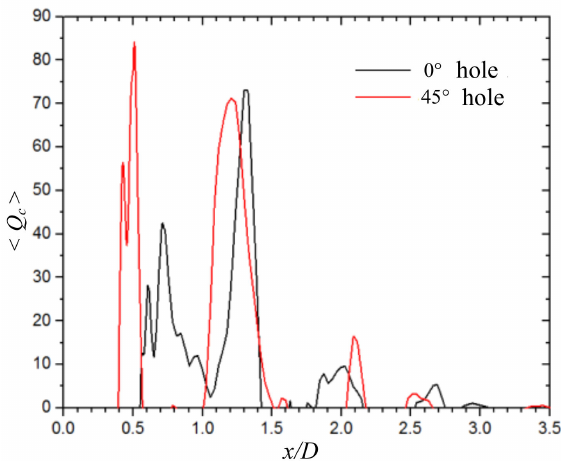
Figure 10. The mean second invariant in jet space at y/D = 0.05 along the x